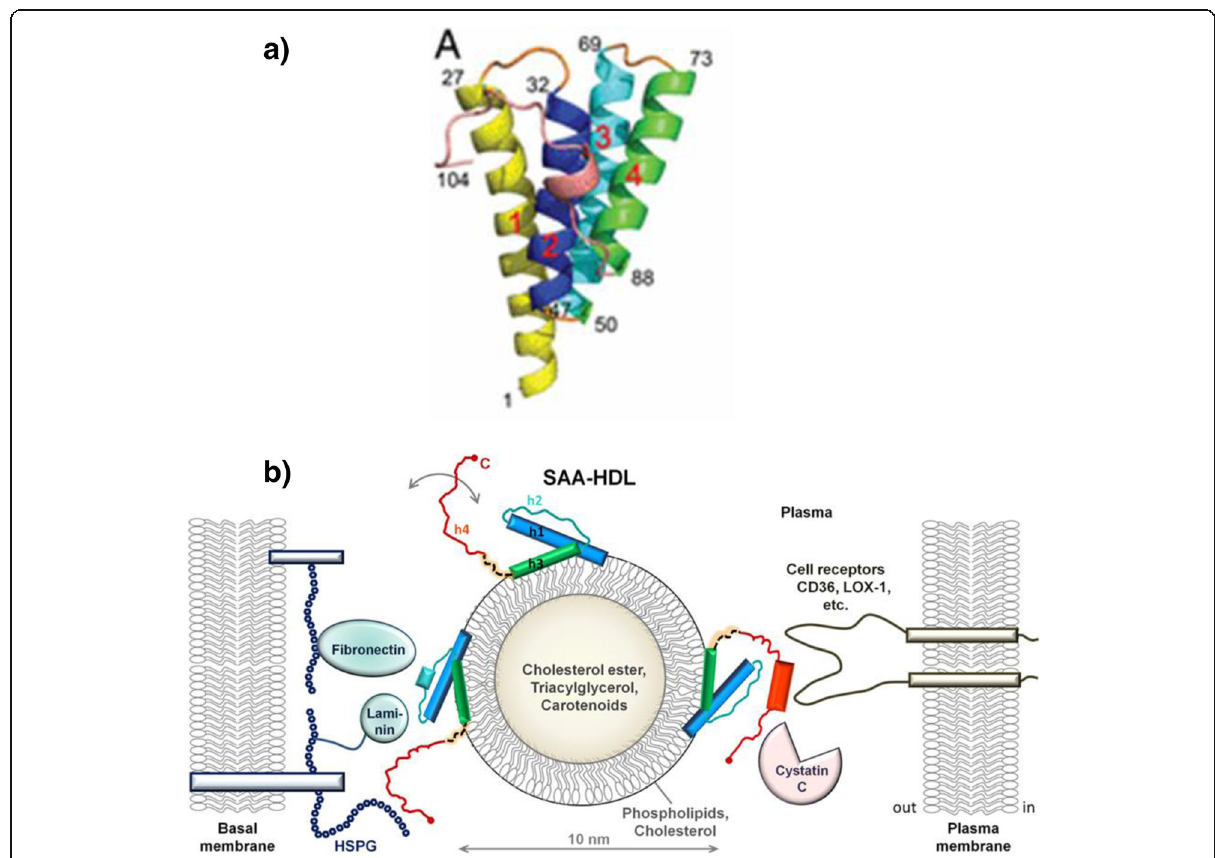
Fig. 3 a Monomeric three-dimensional structure of SAA1.1 (Lu et al. (2014), Copyright [2014], National Academy of Sciences, used by permission). Note 4 α -helices 1 (aa 1-27), 2 (aa 32-47), 3 (aa 50-69), 4 (aa 73-88) and C-terminal tail (aa 89-104). b Proposed model for SAA interaction on HDL surface showing potential binding sites to receptors and other molecules. (Frame and Gursky (2016), Copyright John Wiley and Sons, 2016, used by